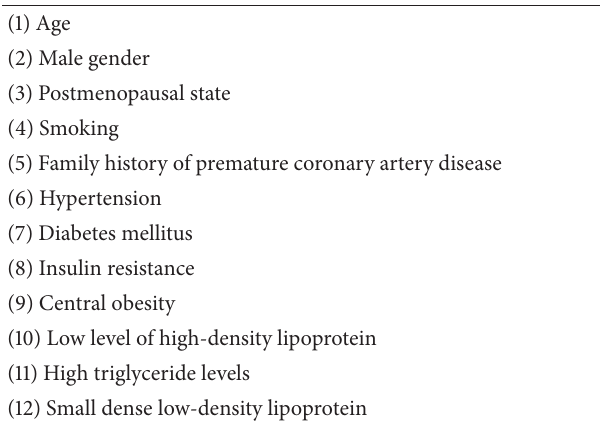
Table 1: Traditional risk factors for cardiovascular disease.